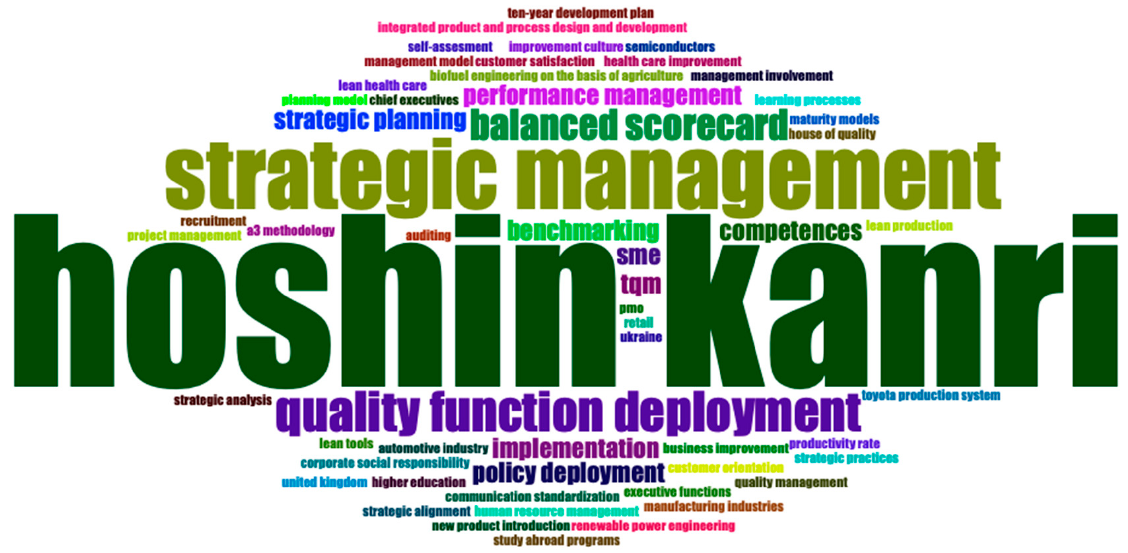
Figure 5. Author’s keywords.